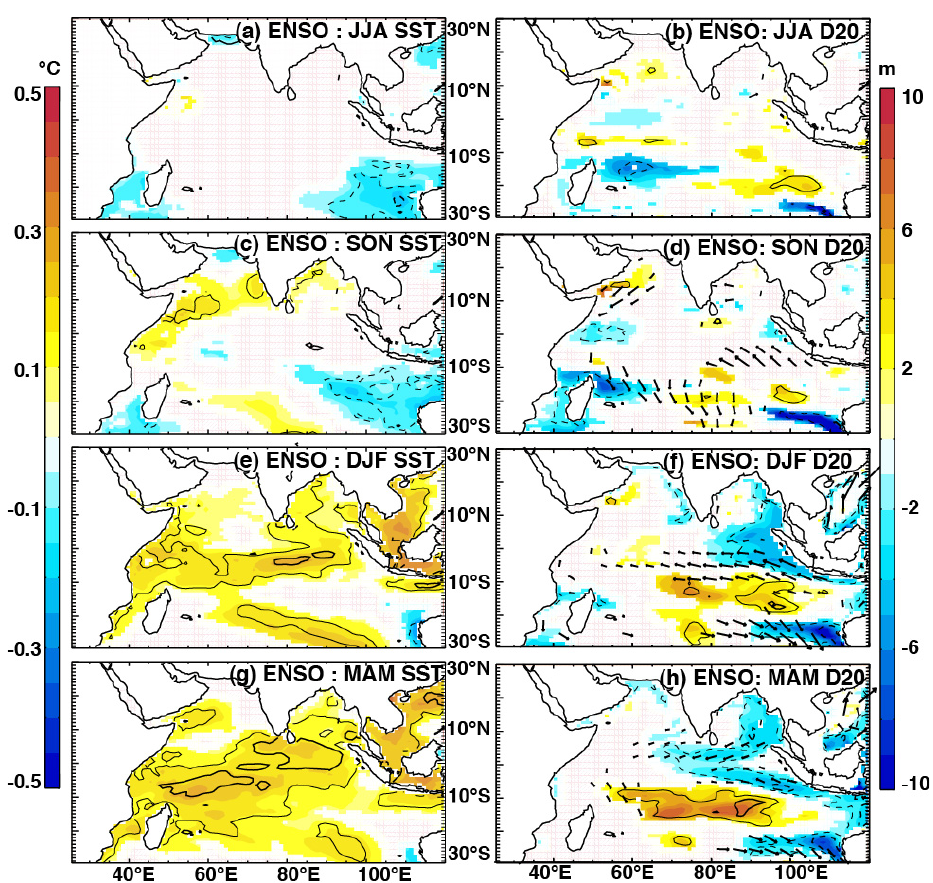
Fig. 5. The impacts of ENSO on SST (left panels), D20 (colour; right panels) and wind stress (arrows; right panels), as indicated by partial regression coefficients of their anomalies regressed onto the ENSO index, having removed the influence of IOD (Eqs. 4–6). Regressions were computed for the period 1961–2001 and their coefficients were drawn only when beyond a 90% significance level. Thin and thick contours indicate correlation coefficients of 0.4 and 0.6 respectively, while solid (dashed) lines represent positive (negative)